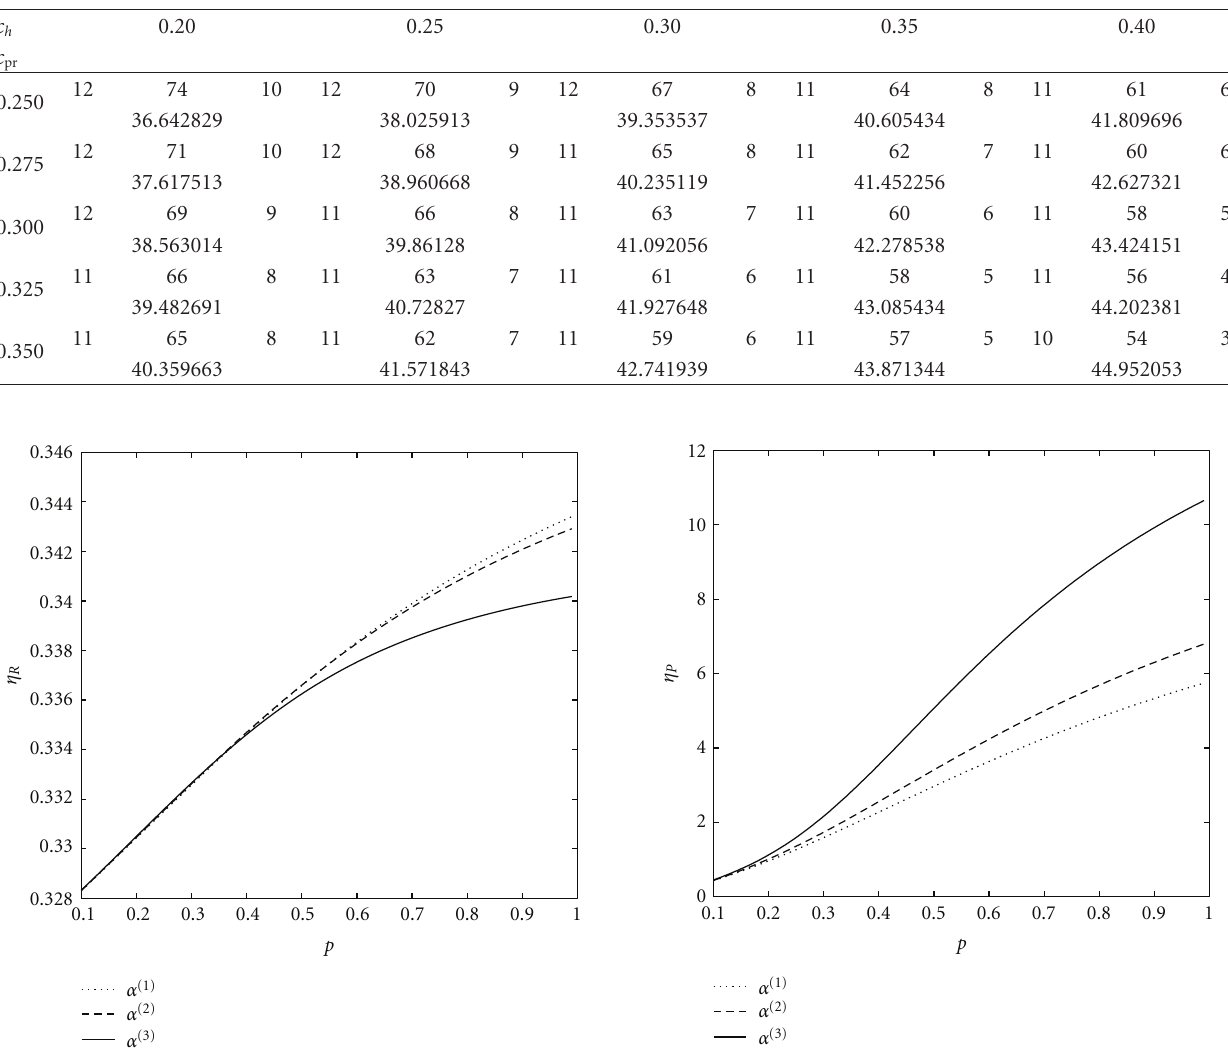
Table 12: Optimal values corresponding to various holding and perishable costs ( c s = 15, c sh = 5, c p = 3).